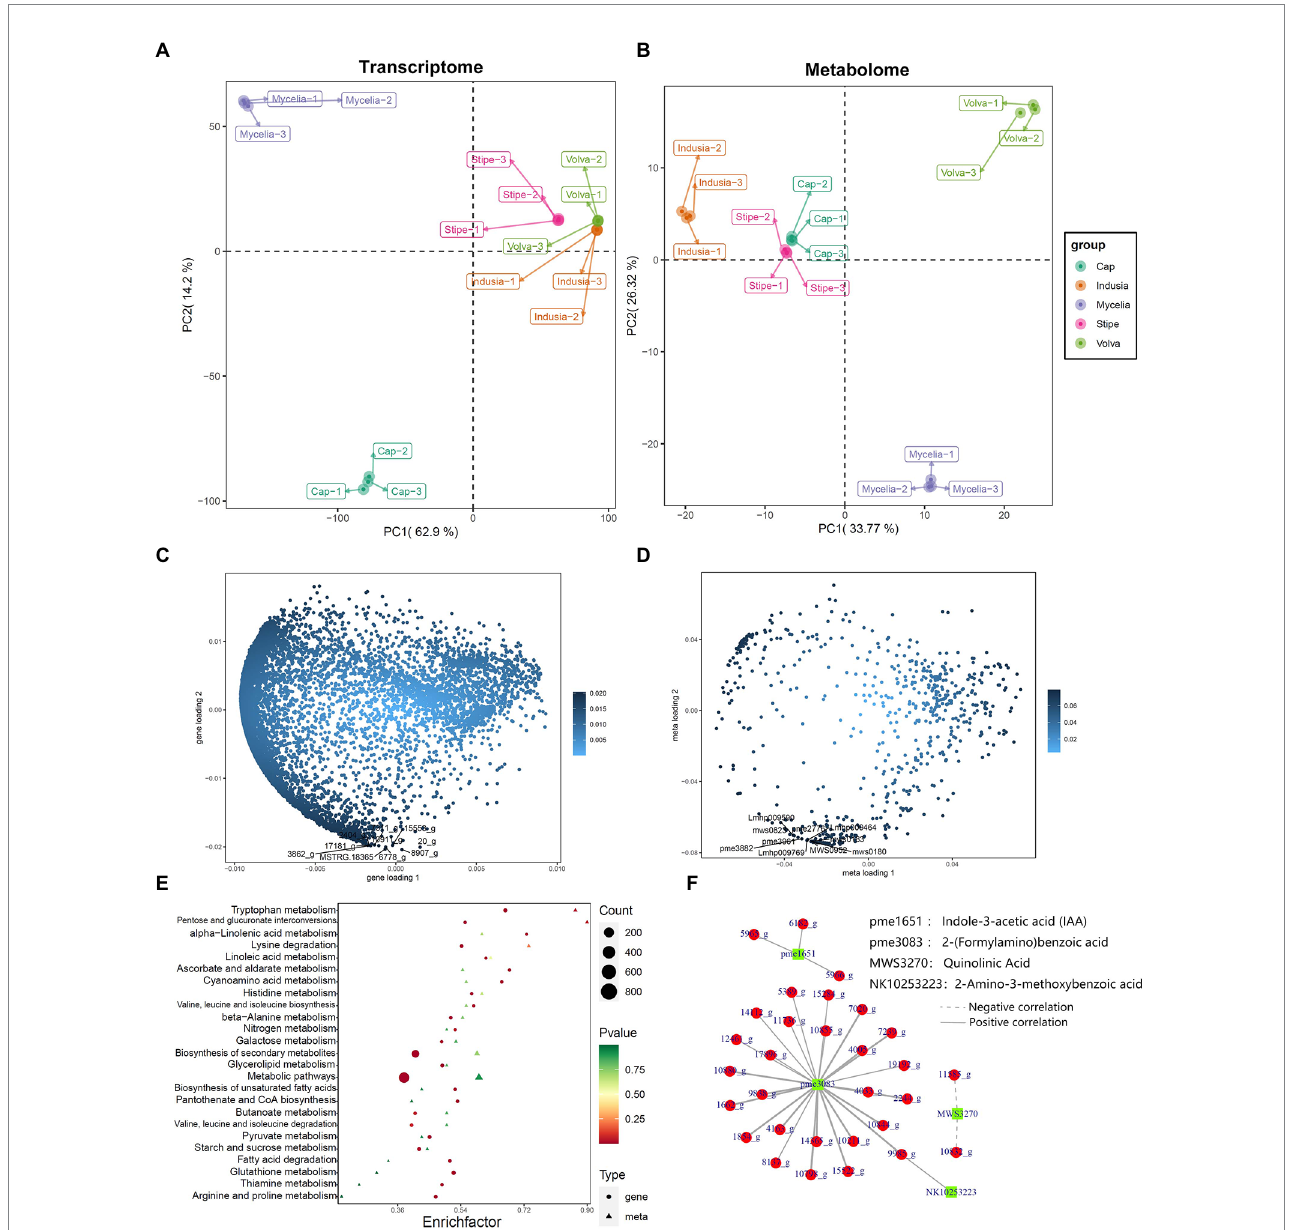
FIGURE 10 Correlation between metabolome and transcriptome of DI. (A,B) Metabolome and transcriptome PCA analysis. The abscissa represents PC1, and the ordinate represents PC2. (C,D) Metabolome and transcriptome O2PLS analysis. The abscissa represents the one-dimensional gene (C) /metabolite (D) loading value, and the ordinate represents the two-dimensional gene (C) /metabolite (D) loading value. (E) KEGG pathway enrichment analysis of DEGs and differential metabolites between cap and mycelia. The abscissa represents the corresponding enrichment factor of each pathway, and the ordinate represents the pathway name (sorted by value of p ). The color of the dots and the triangles reflects the value of p of the genes and corresponding metabolites; the redder the dots/triangle, the more significant the enrichment. The size of the dot/triangle represents the number of differential genes and metabolites. Figure legend is shown on the right side. (F) Pearson correlation network between DEGs and metabolites. Red represents DEGs, and the green represents